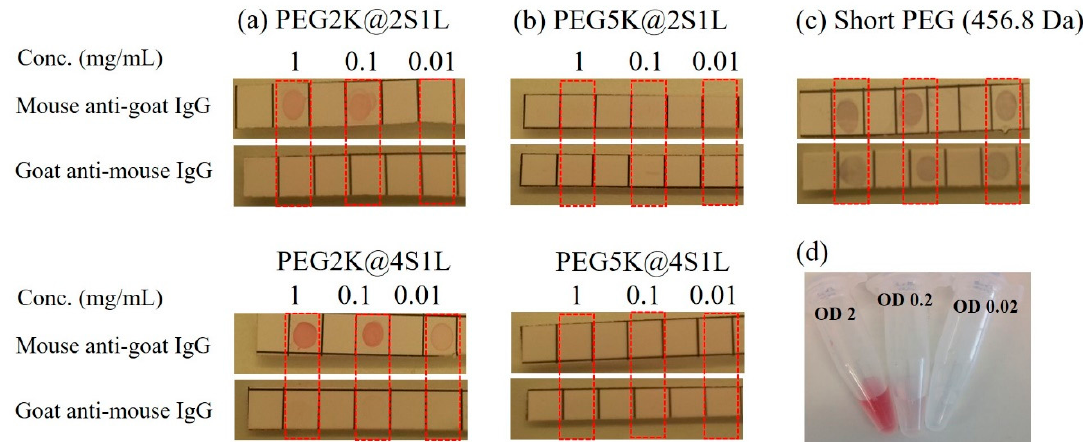
Figure 3. Dot-blot strips analysis of immune-binding efficiency for PEGylated AuNPs (17 nm) coated with various ratios of short to long PEG molecules. Photographic images of the dot-blot strips showing the specific (Mousse anti-goat IgG strips) and non-specific (Goat anti-mousse IgG strips) adsorption of goat anti-mouse IgG bioconjugated AuNP probes with various PEG coatings: ( a ) PEG2K@2S1L and PEG2K@4S1L; ( b ) PEG5K@2S1L and PEG5K4S1L; ( c ) only short PEG. ( d ) Photographic image of the AuNP solutions at the tested concentrations.